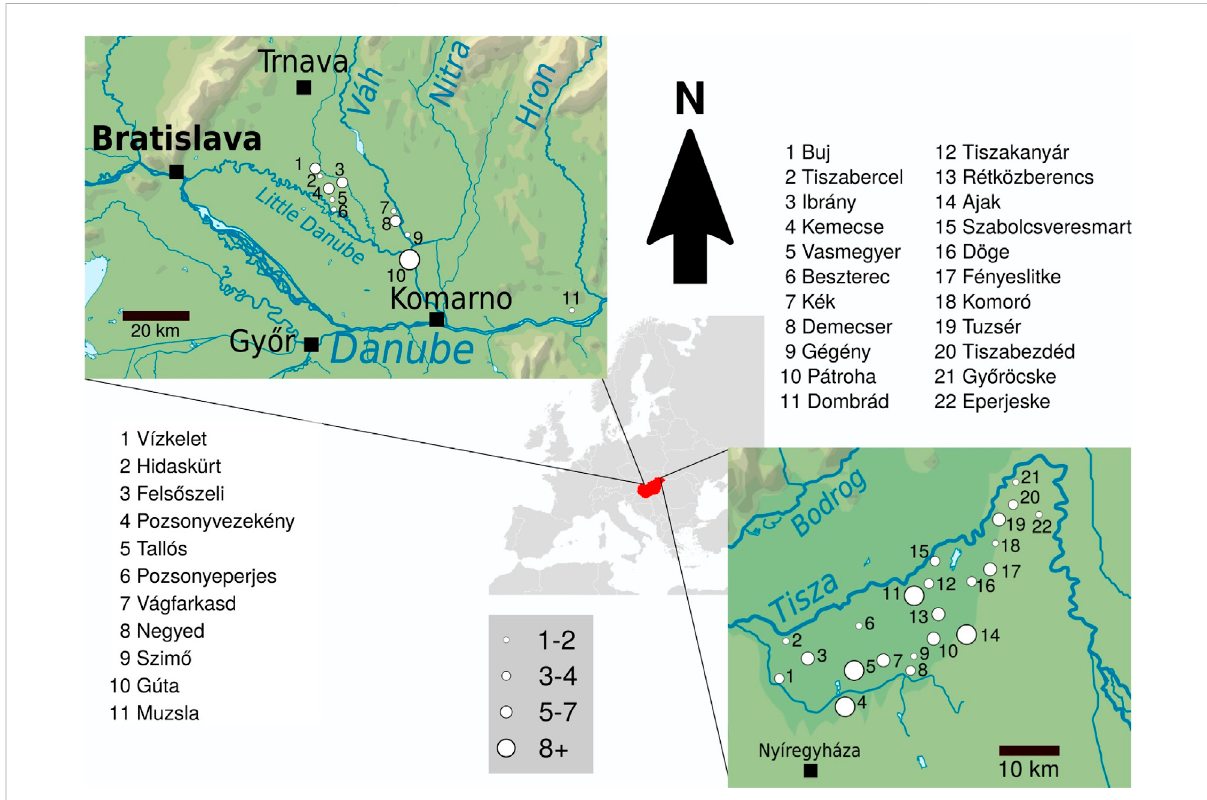
FIGURE 1 Thegeographicaldistributionof48and106non-relatedHungarianmalesfromVáhvalleyandRétköz,respectively.Leftside:Mapandlistofthe sampledVáhvalleysettlements.Rightside:MapandlistofthesampledRétközsettlements.Settlementsaremarkedwithcirclesofdifferentsizesthat are proportional to the number of individuals